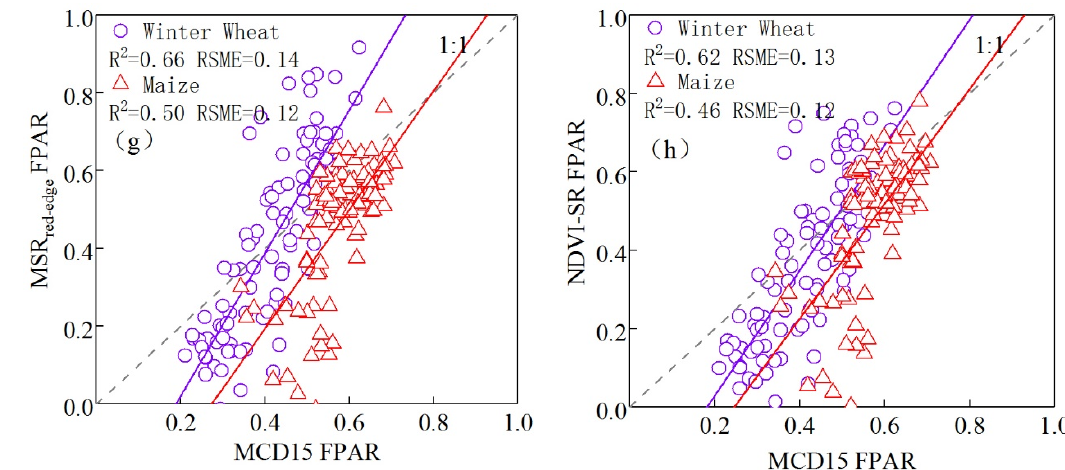
Figure 13. Correlation between the predicted FPAR and the reference data in the main growing seasons. ( a – h ) Correlation between the FPAR retrieved by the NDVI, SR, MSR, EVI, NDVI red-edge , SR red-edge , MSR red-edge , NDVI-SR, and MCD15A3H FPAR predictions.